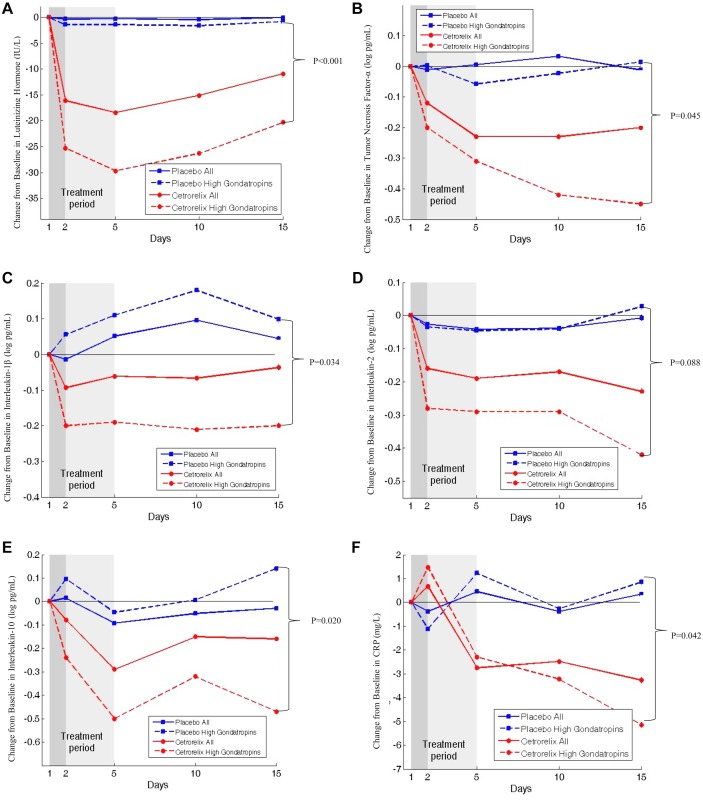
Change in Hormonal and Immunological Variables from Baseline.P values represent the baseline-adjusted between-group difference using analysis-of-covariance between the high-gonadotropin cetrorelix group (N = 27) and high-gonadotropin placebo group (N = 26) on day 15. There were no significant differences between the high-gonadotropin groups at baseline, day 2, day 5, or day 10; except for luteinizing hormone, which was significantly reduced in the cetrorelix groups compared to placebo groups already by day 2 onwards. Panels A-F show the change from baseline in luteinizing hormone, tumor necrosis factor-α, interleukin-1β, interleukin-2, interleukin-10, and C-reactive protein respectively. A: Change from Baseline in Luteinizing Hormone Between Groups. B: Change from Baseline in Tumor Necrosis Factor-α Between Groups. C: Change from Baseline in Interleukin-1β Between Groups. D: Change from Baseline in Interleukin-2 Between Groups. E: Change from Baseline in Interleukin-10 Between Groups. F: Change from Baseline in C-Reactive Protein (CRP) Between Groups.